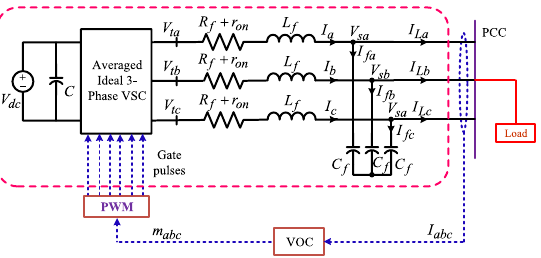
Fig. 4 VSM implementation in an islanded MG